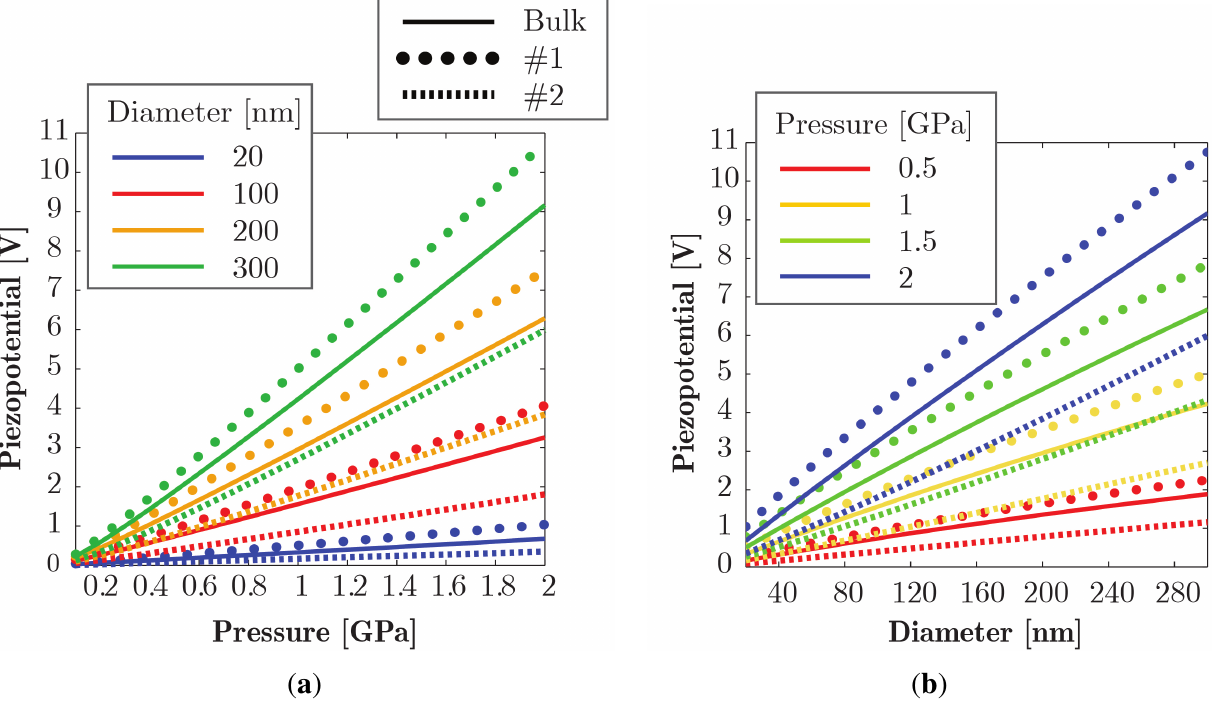
Figure 10. Simulation results comparing the piezopotential V from bulk versus size effect (SE) models over a D range of 20–300 nm and pressure p from 0.1 GPa up to 2 GPa, for conical NWs with aspect ratio k = 5 : (a) piezopotential versus pressure; (b) piezopotential versus